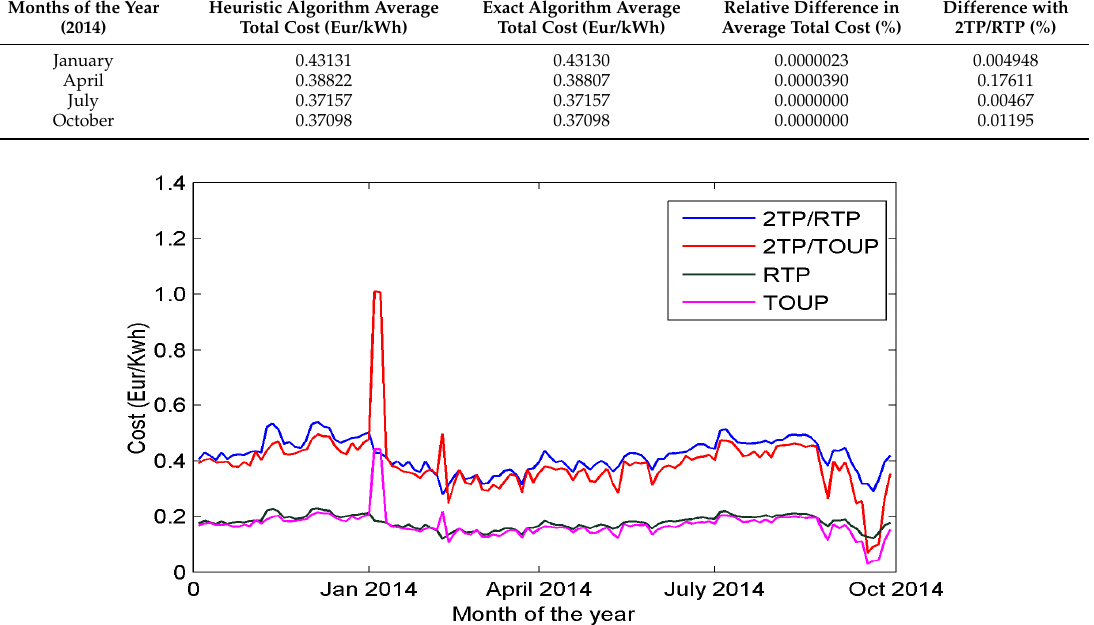
Figure 6. RTP and RTP/2TP vs. TOUP and 2TP/TOUP cost scheduling solution for heuristic algorithm.